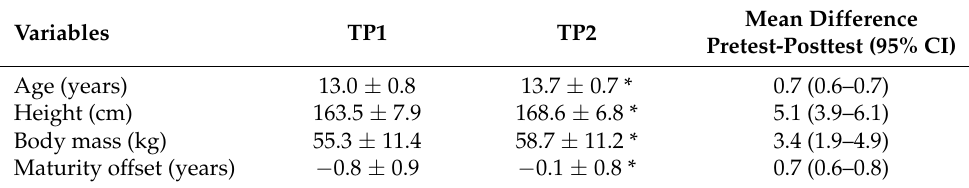
Table 1. Descriptive characteristics of the participants during the two testing